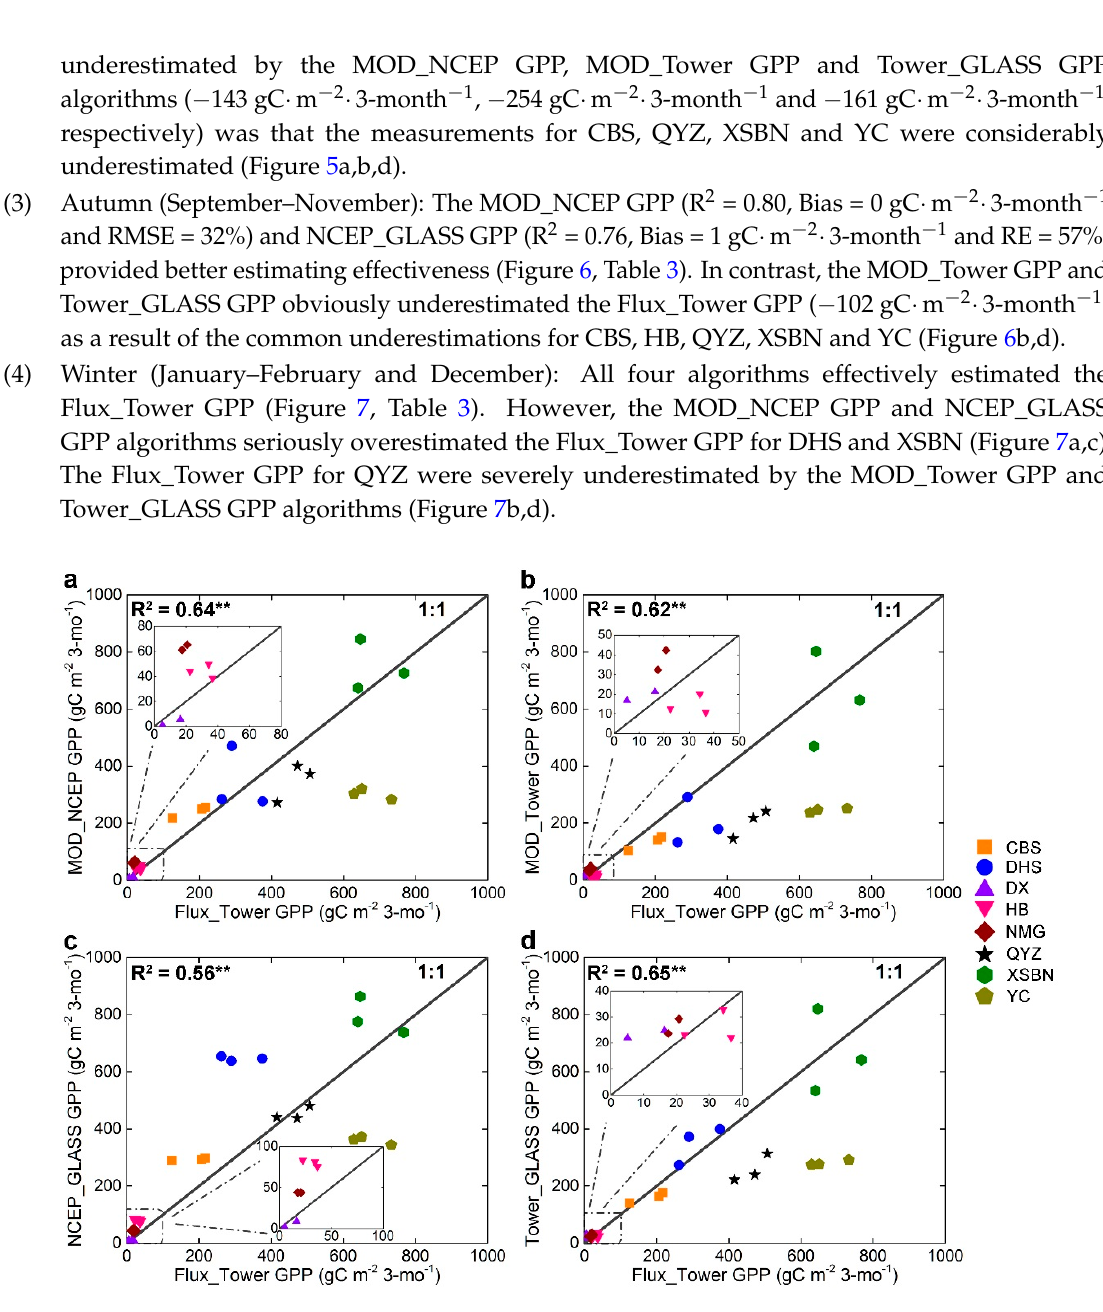
Figure 4. Comparisons of Flux_Tower GPP for spring (March–May) with: ( a ) MOD_NCEP GPP; ( b ) MOD_Tower GPP; ( c ) NCEP_GLASS GPP; and ( d ) Tower_GLASS GPP. Significance levels: ** p < 0.01.